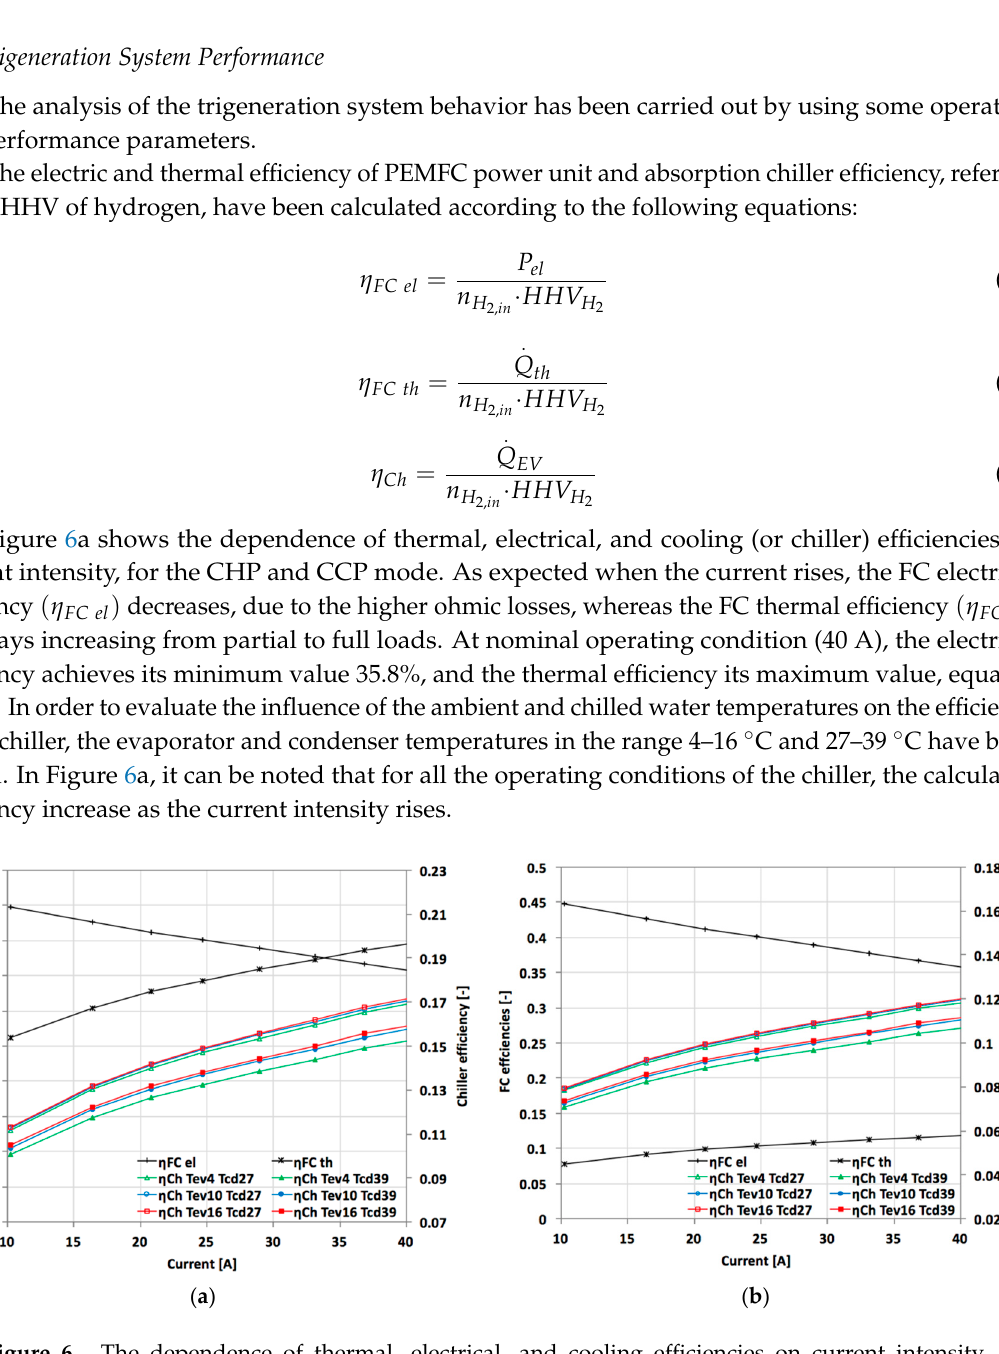
Figure 6. The dependence of thermal, electrical, and cooling efficiencies on current intensity. ( a ) The CHP and CCP mode; ( b ) The CCHP mode.